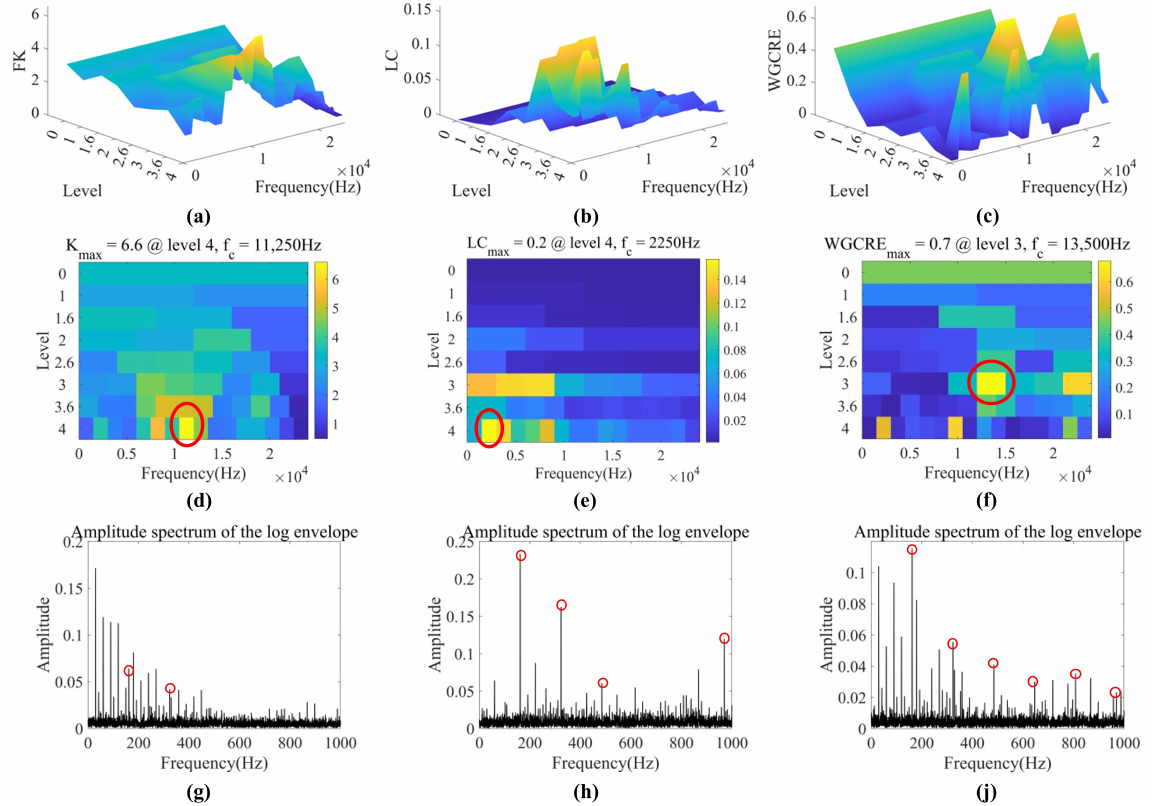
Figure 14. Optimal bands extraction of Case 3 (inner race fault). ( a – f ) are 3D and 2D FK, LC , and WGCRE –gram, respectively (optimal bands are circled in red). ( g – j ) are LES of FK, LC , and WGCRE , respectively (BPFIs with harmonics are marked with red circles).